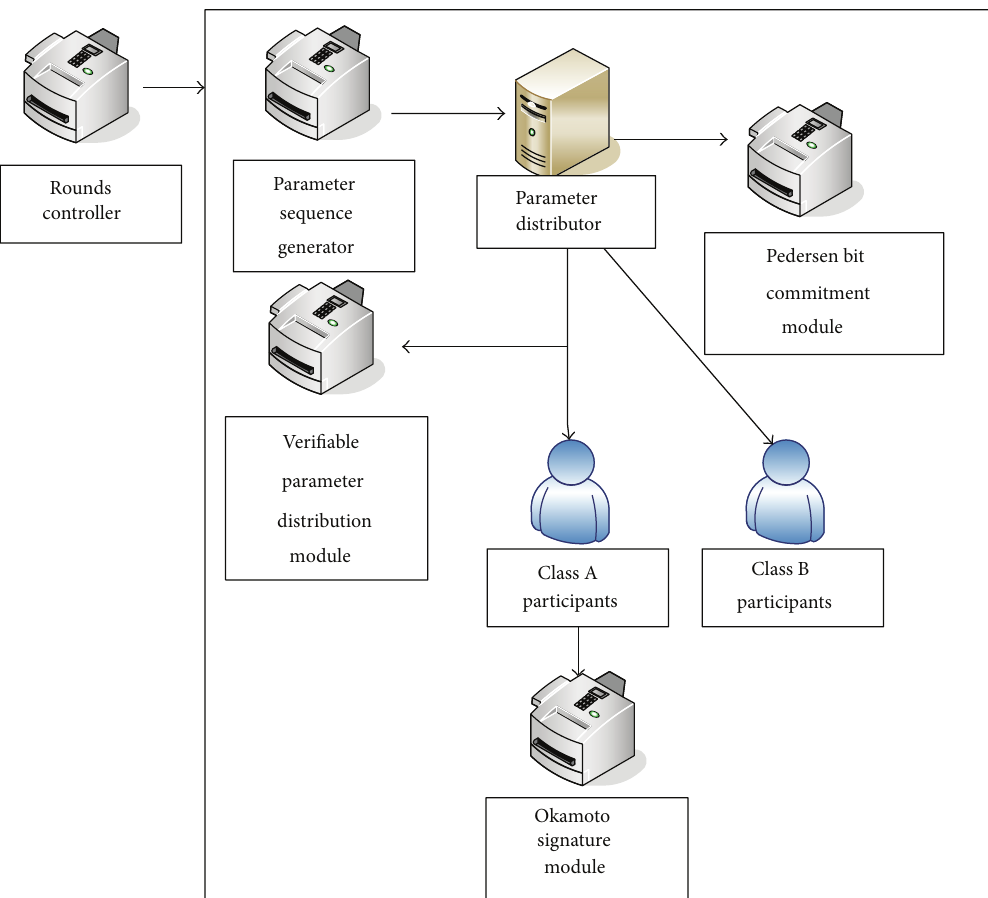
Figure 1: The structure diagram of